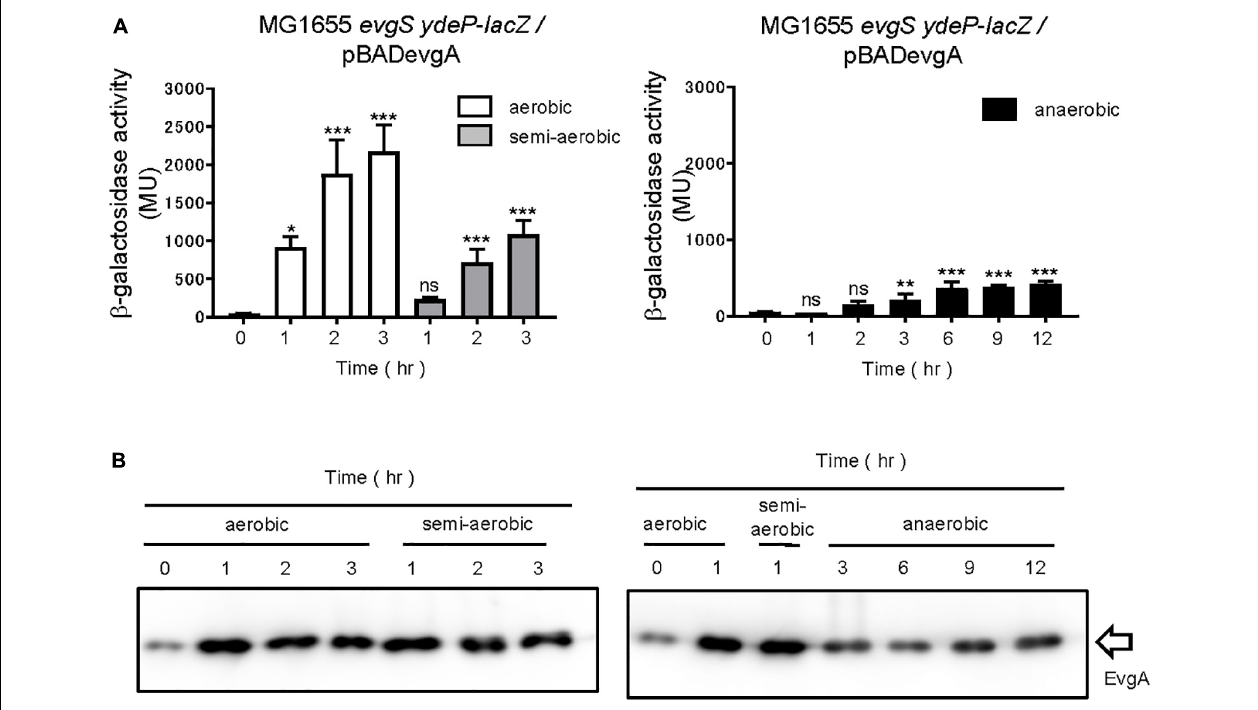
FIGURE 3 | Aeration is not required for activating EvgS/EvgA by EvgA-overproduction. (A) Activity of the ydeP-lacZ reporter by inducing EvgA from pBADevgA. Cells were grown in EvgS-activation medium with 1% arabinose under aerobic (white bars), semi-aerobic (gray bars), or anaerobic condition (black bars) at 37 ◦ C. Optical density at 600 nm of the cell cultures subjected to reporter assays is shown in Supplementary Figure 4 . Data represent the average of three biologically independent replicates. Error bars indicate the standard deviation, and statistical analyses of each redox condition group were performed as described in Figure 1 .